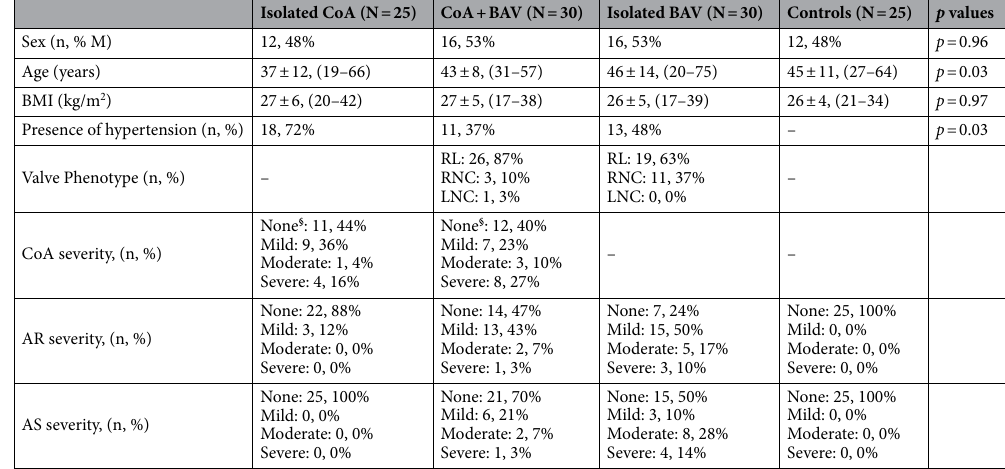
Table 1. Patient demographic and clinical characteristics. AR aortic regurgitation, AS aortic stenosis, RL right-left leaflet non-separation, RNC right-non coronary leaflet non-separation, LNC left-non coronary leaflet non-separation, BMI body mass index. None § = patients with repaired CoA and no residual narrowing.